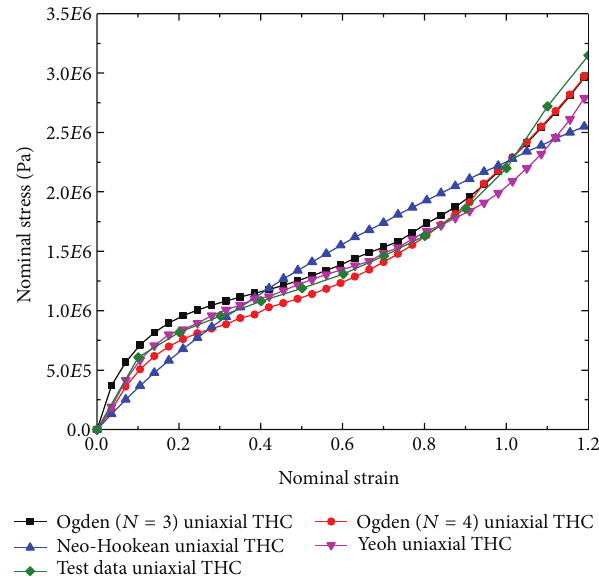
Figure 1: The experiment and fitting curve of undertread rubber. inflation pressure 900 kPa, with a load of 35.5 kN. The rubber materials can endure large elastic deformation, because of the high linearity of the stress-strain relationship. Rubber is an isotropic hyperelastic material and can be described by the Ogden, the Neo-Hookean, and the Yeoh model [11]. However, the Yeoh model differs from other models in that it only depends on the first strain invariant; thus it can be used to fit various models of deformation with the uniaxial tension